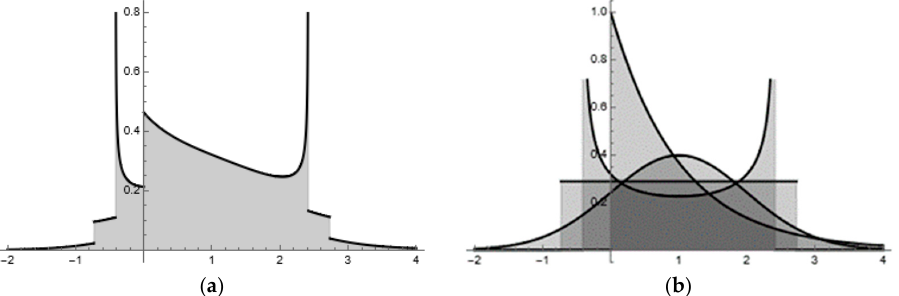
Figure 1. The specimen mixture RV composed of a normal, exponential, uniform, and sinusoidal RV with equal mixing weights (i.e., ¼). Left ( a ): its PDF. Right ( b ): overlaid individual RV PDFs.